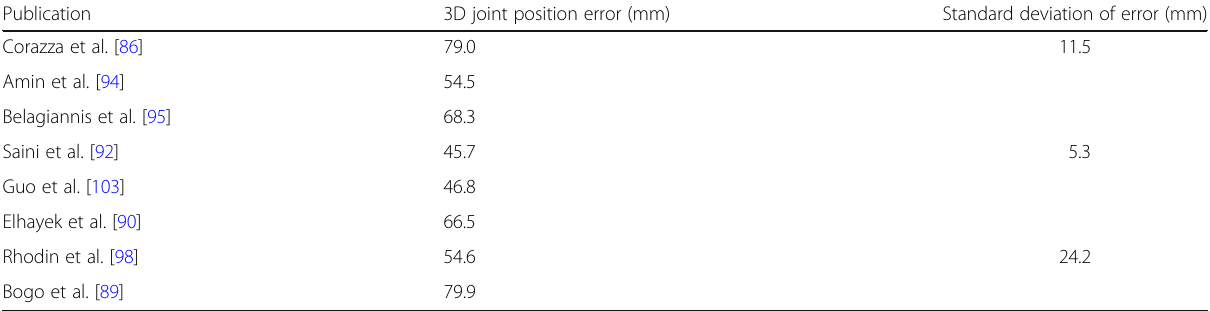
Table 3 Selection of published validation results against the HumanEva datasets